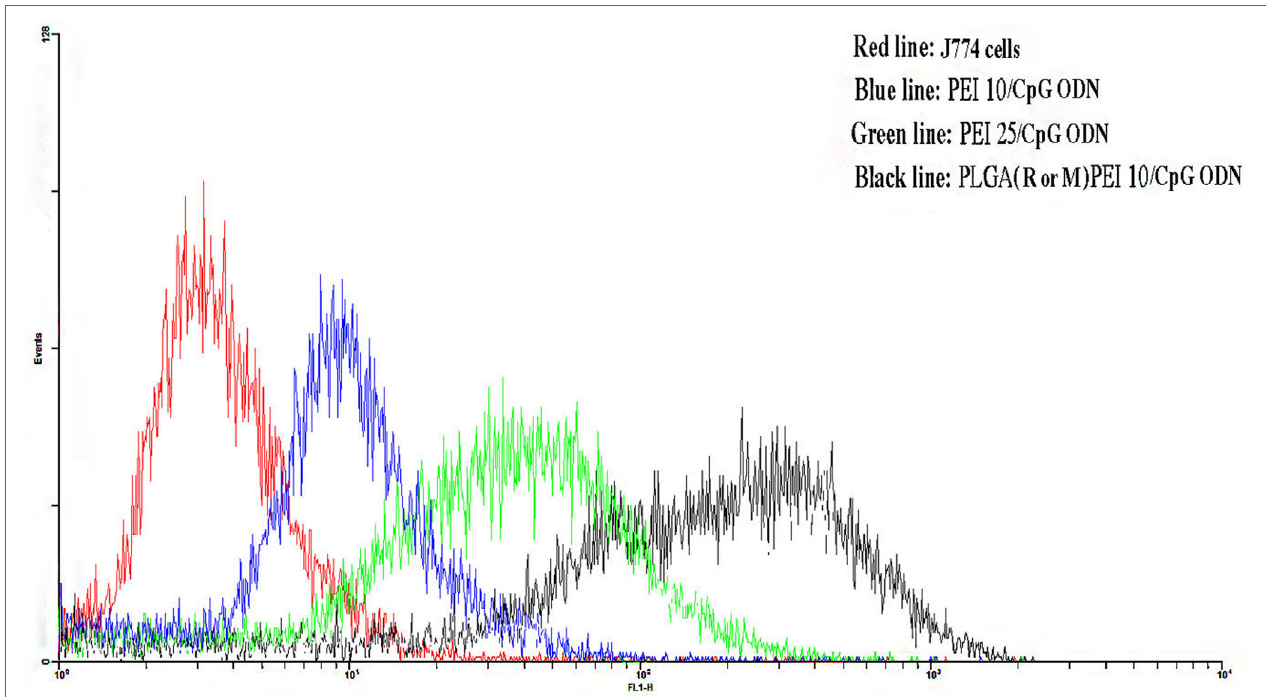
FigUre 7 | Flow cytometry histogram showing the uptake of polyethylenimine (PEI) 10/cytosine–phosphorothioate–guanine oligodeoxynucleotide (CpG ODN, blue line) and PEI25/CpG ODN (green line) as positive control groups and poly(lactic-co-glycolic) acid (R or M)/PEI10/CpG ODN (black line) in J774 cells after 48 h incubation. J774 cells were used as negative control group. The R or M stands for either R848 or monophosphoryl lipid